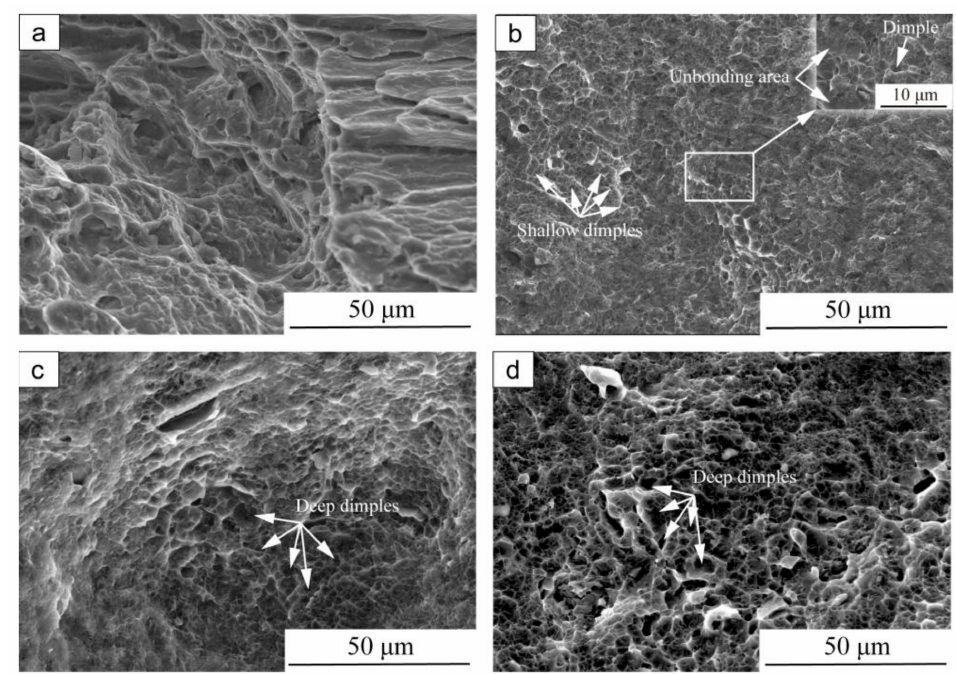
Figure 6. SEM fracture surface morphologies of compressed specimens (350 ◦ C, ε = 0.6), followed by post-heating treatment at 400 ◦ C with different holding time: ( a ) without holding, ( b ) 2 h, ( c ) 8 h, ( d ) 12